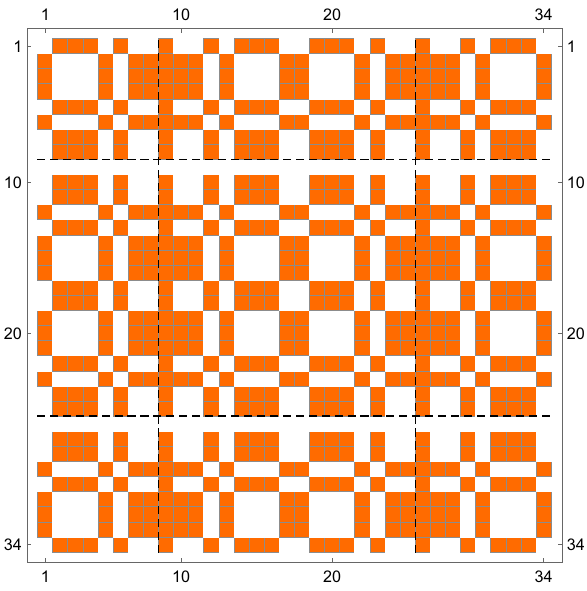
Fig. 2 A mosaic of four MURA 17 × 17 matrices, after global permu- tations both of raws and columms. Black dashed lines delimit a basic central mask, the other three are spread in the remaining sectors. The orange pads correspond to entry 1 and the white ones correspond to